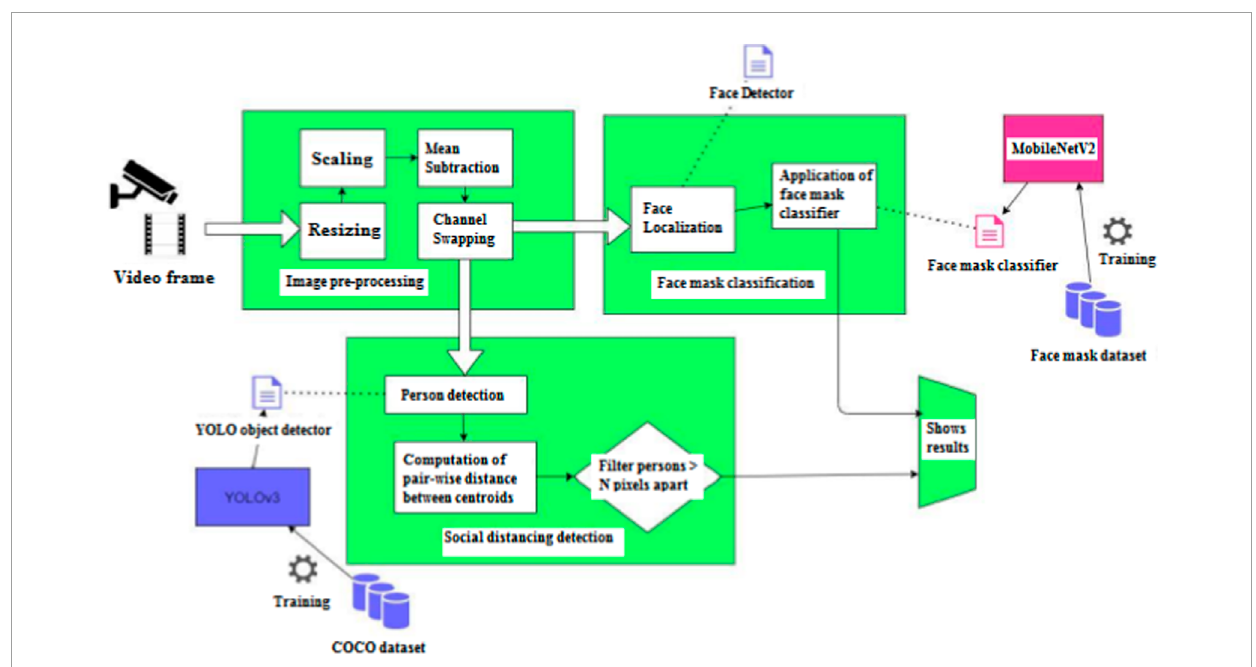
FIGURE 1 Proposed Architecture of Face mask and Social distancing